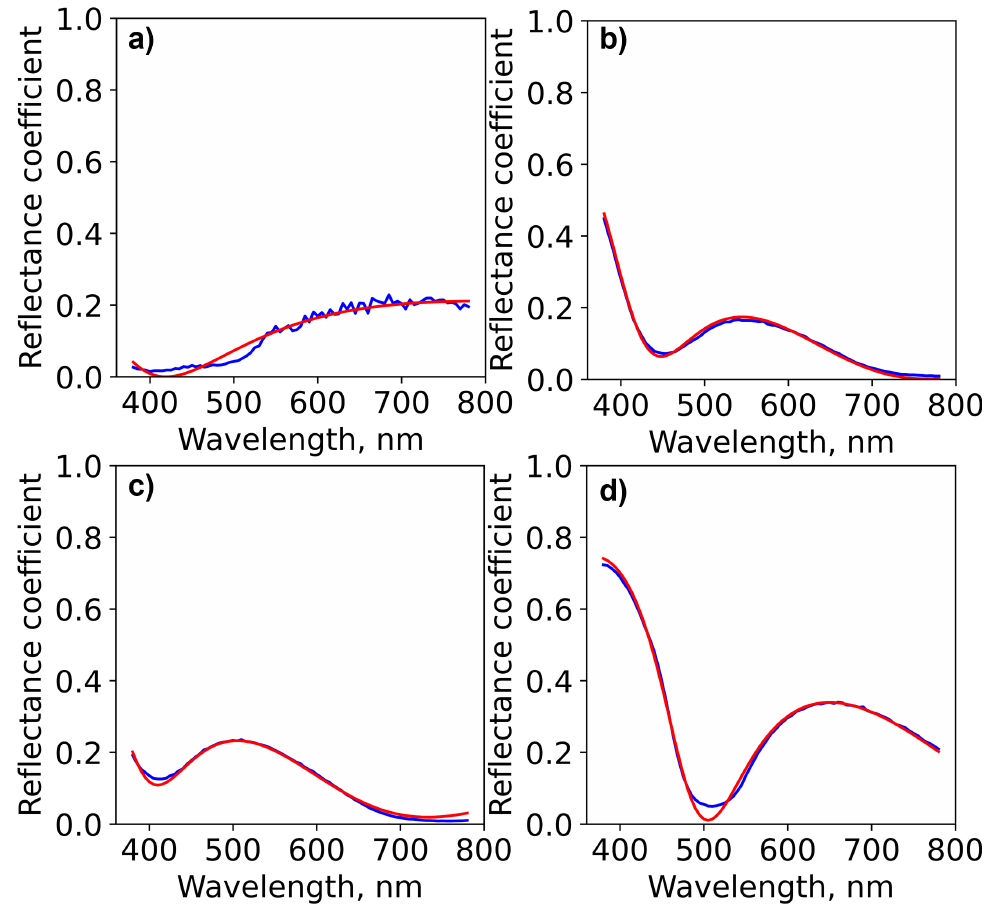
Figure 5. A selection of graphs showing example plots corresponding to various levels of accuracy. These are 90%, 95%, 94%, and finally 97%, where the predicted layer depths were [83.3 56.4 89.6 46.0 66.7 3.2], [27.1 25.6 58.8 49.0 65.4 26.9], [27.4 43.8 31.2 42.5 52.9 14.8] and [69.5 63.5 61.5 38.9 17.9 21.9]